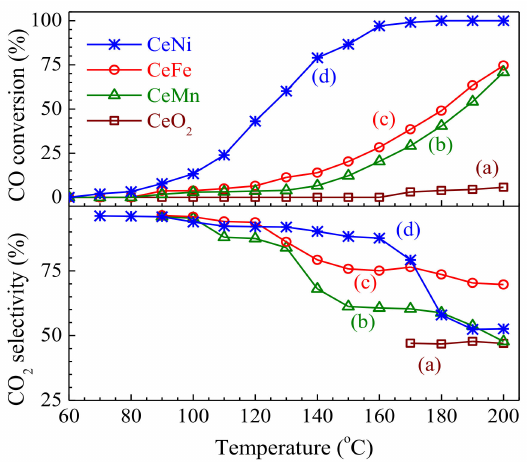
Figure 10. Light-off profiles (temperature-programmed reaction) of CO PROX in H 2 -rich stream over CeO 2 and doped CeM mixed oxides with different dopants: ( a ) CeO 2 ; ( b ) CeMn; ( c ) CeFe; ( d )